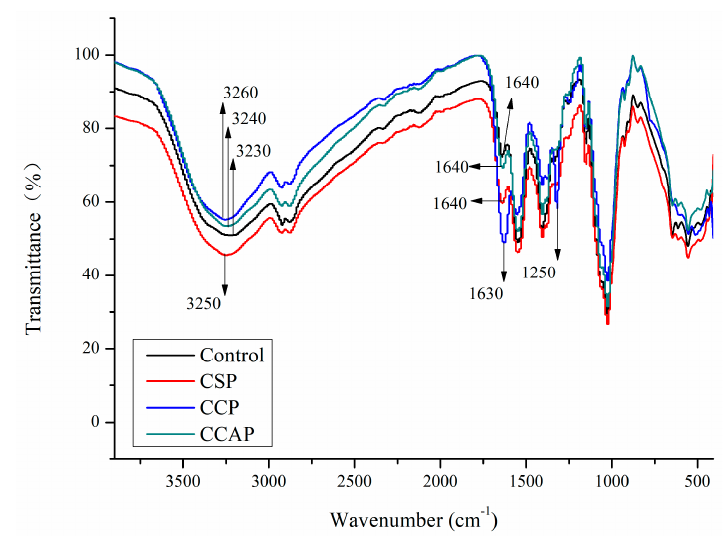
Figure 4. FTIR spectra of chitosan (control) and peptide − containing films. CSP: films from chitosan and soy protein peptides; CCP: films from chitosan and corn protein peptides; CCAP: films from chitosan and casein peptides.